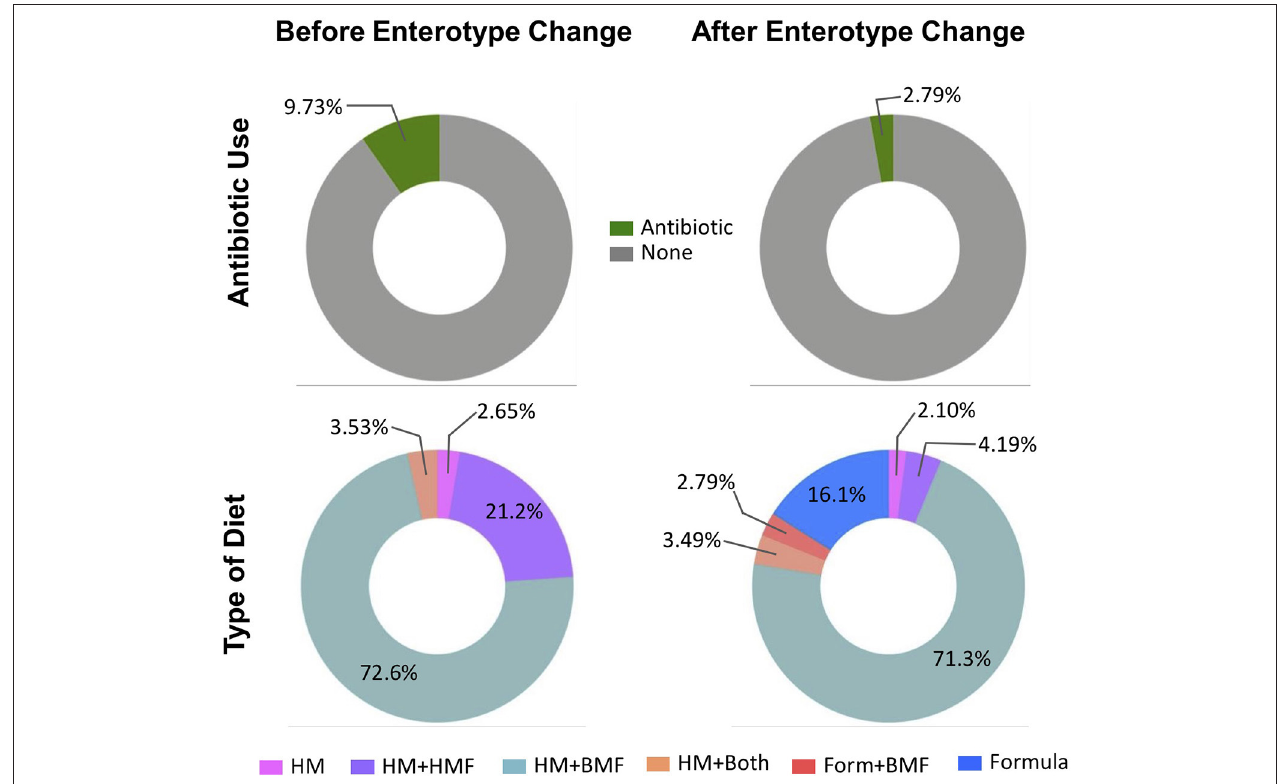
FIGURE 4 | Characteristics before and after change in enterotype. Percentage of antibiotic use and diet category of infants prior moving from on enterotype to another. Before the change of the enterotype, there was a greater use of antibiotics, and HM in combination with fortifiers was the main diet category. Stool samples after they changed to another enterotype were associated with less antibiotic use, and with the introduction to formula feeding. HM, human milk; HMF, human milk-based fortifier; BMF, bovine milk-based fortifier; Form,